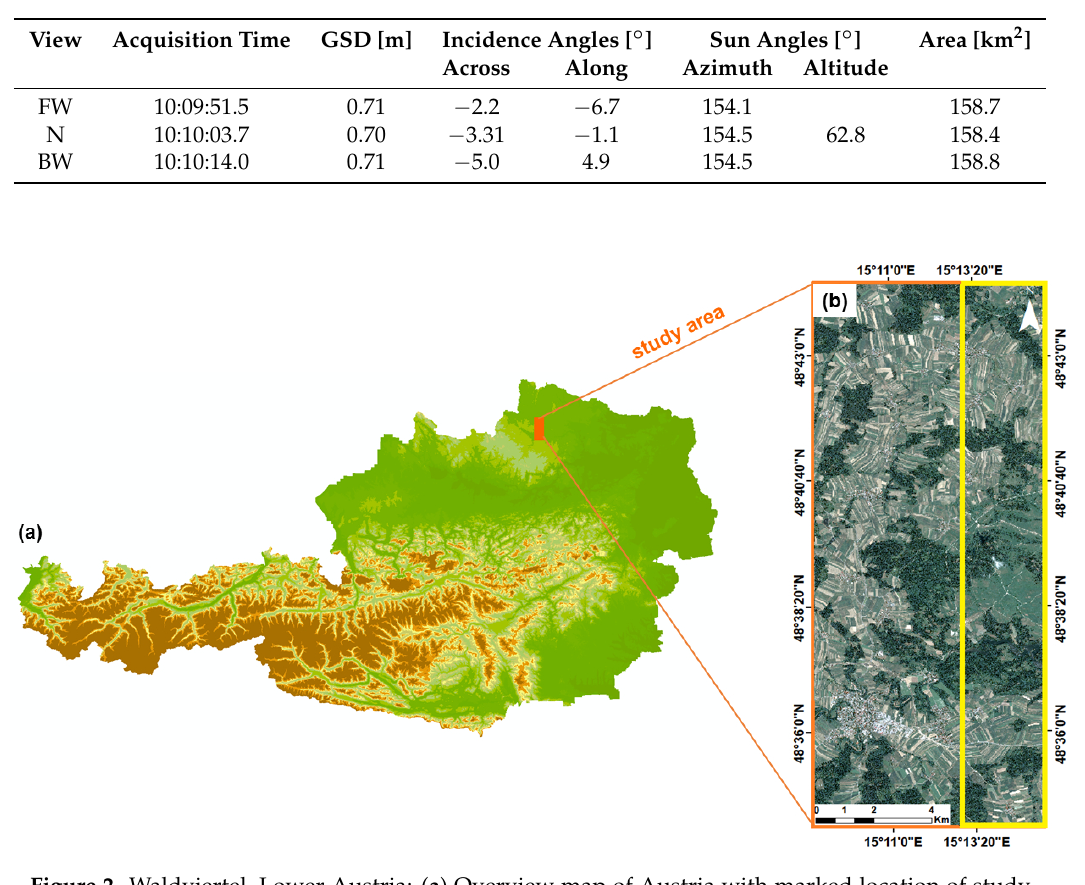
Figure 2. Waldviertel, Lower Austria: ( a ) Overview map of Austria with marked location of study area; and ( b ) Pléiades orthophoto of Waldviertel; the selected area used for semantic segmentation is marked with